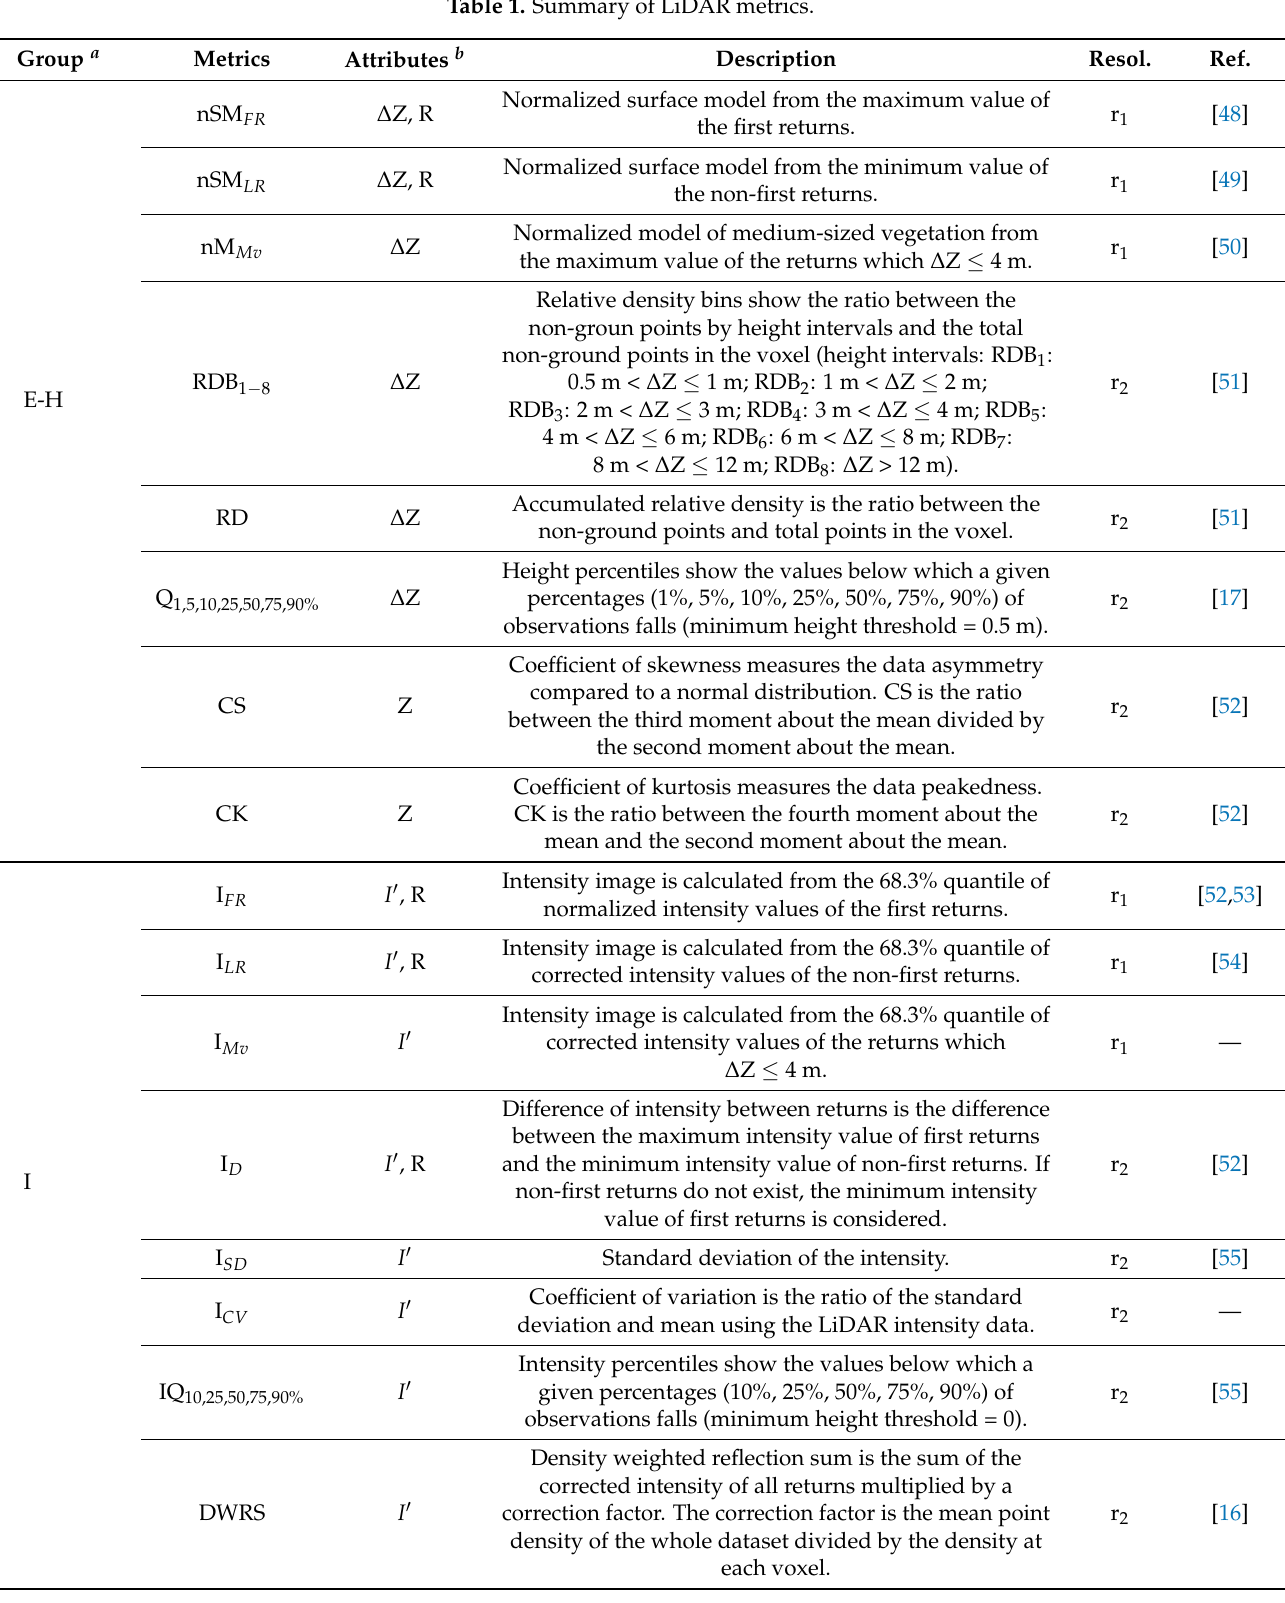
Table 1. Summary of LiDAR